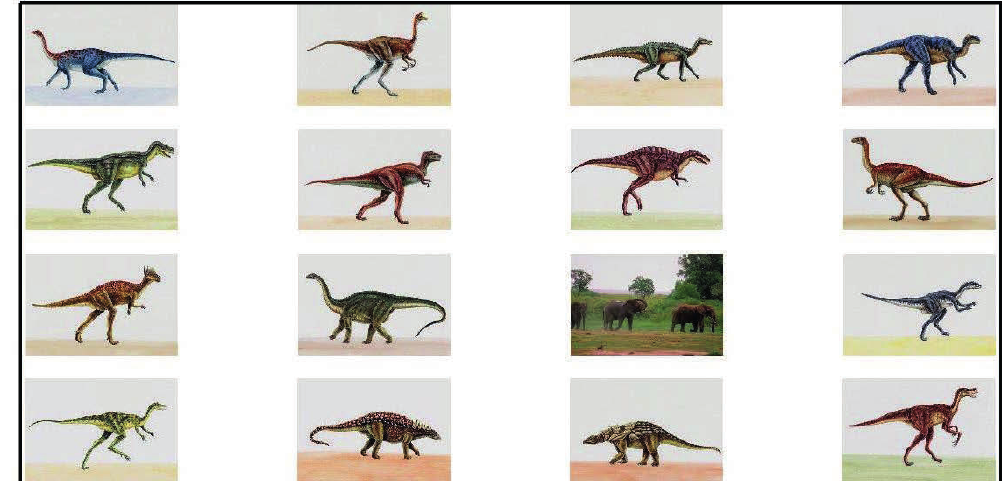
Fig. 11. Dinosaur images retrieved using Framework-1 (EHD-KM).